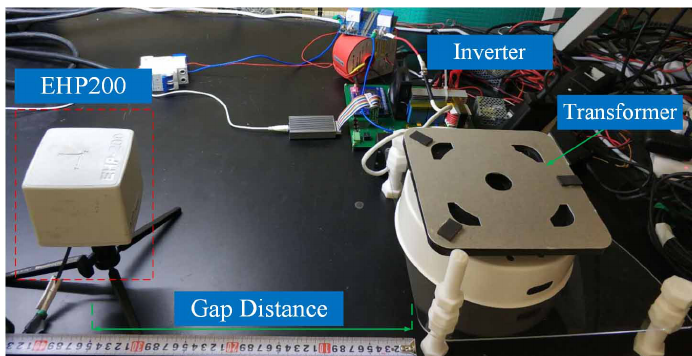
Figure 14. Experimental prototype.